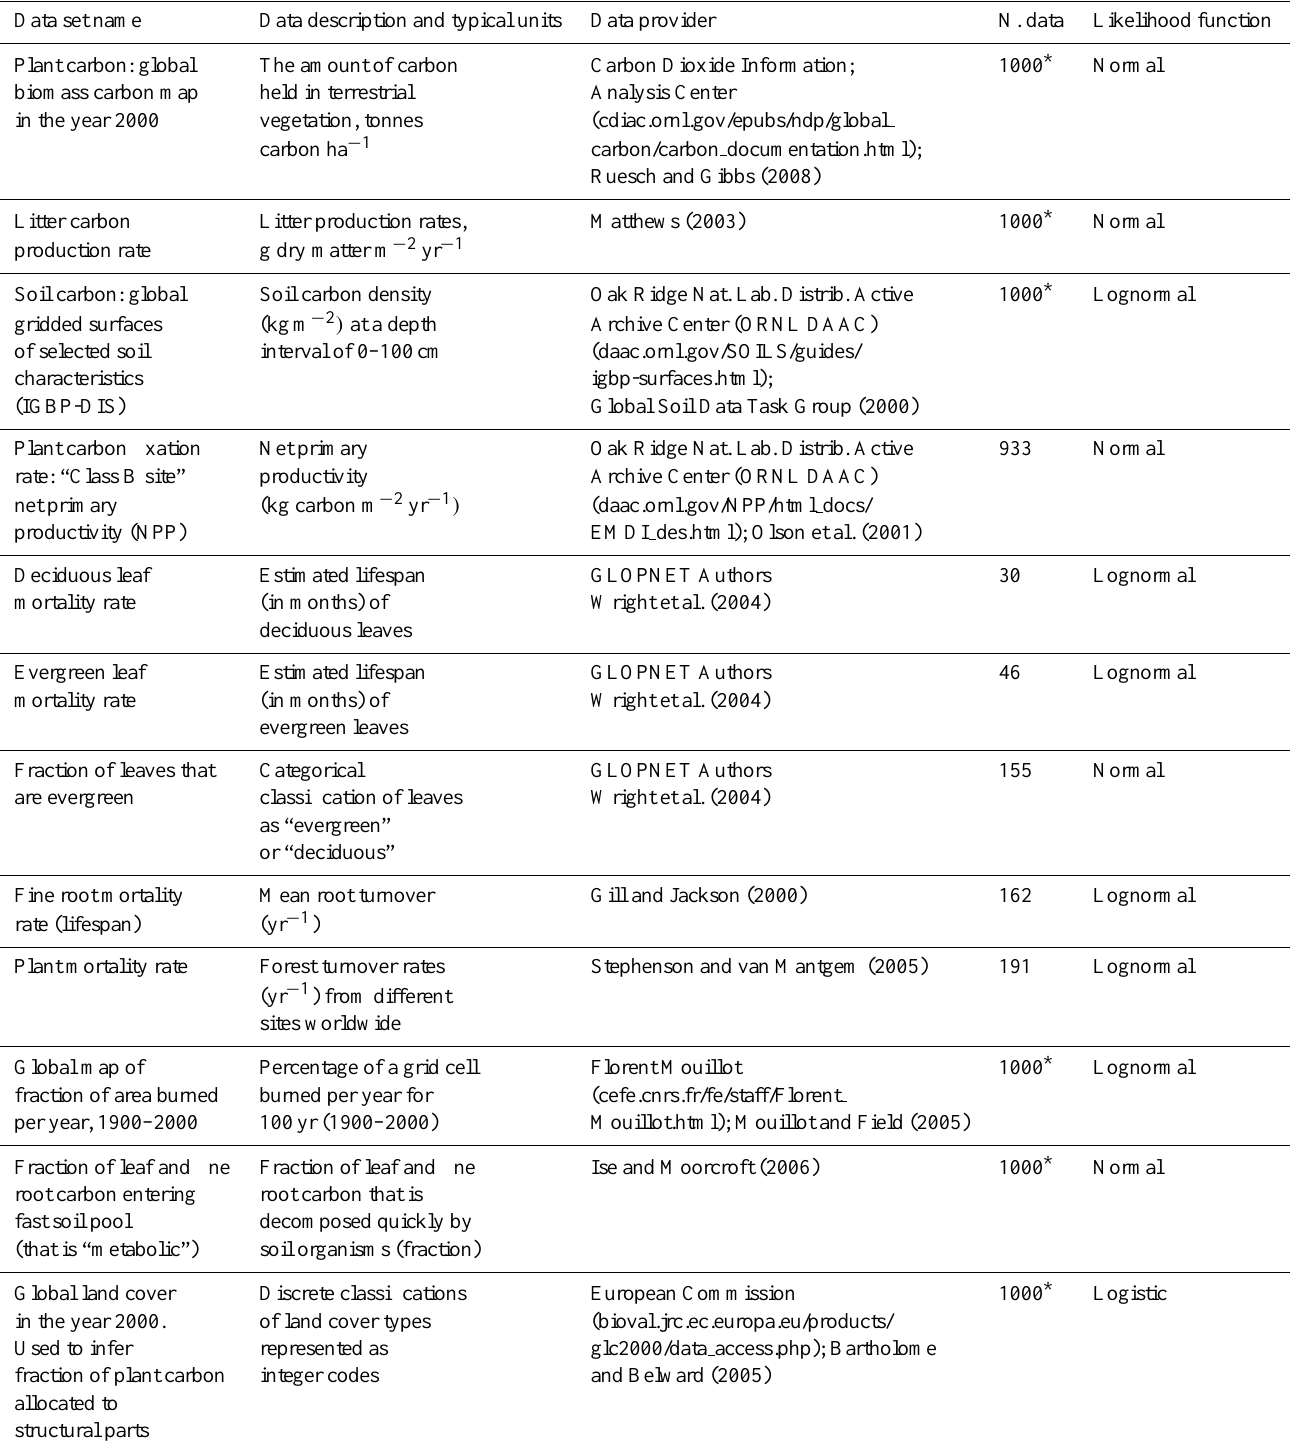
Table 1. Source data on carbon stocks and flows used in our study for model training and